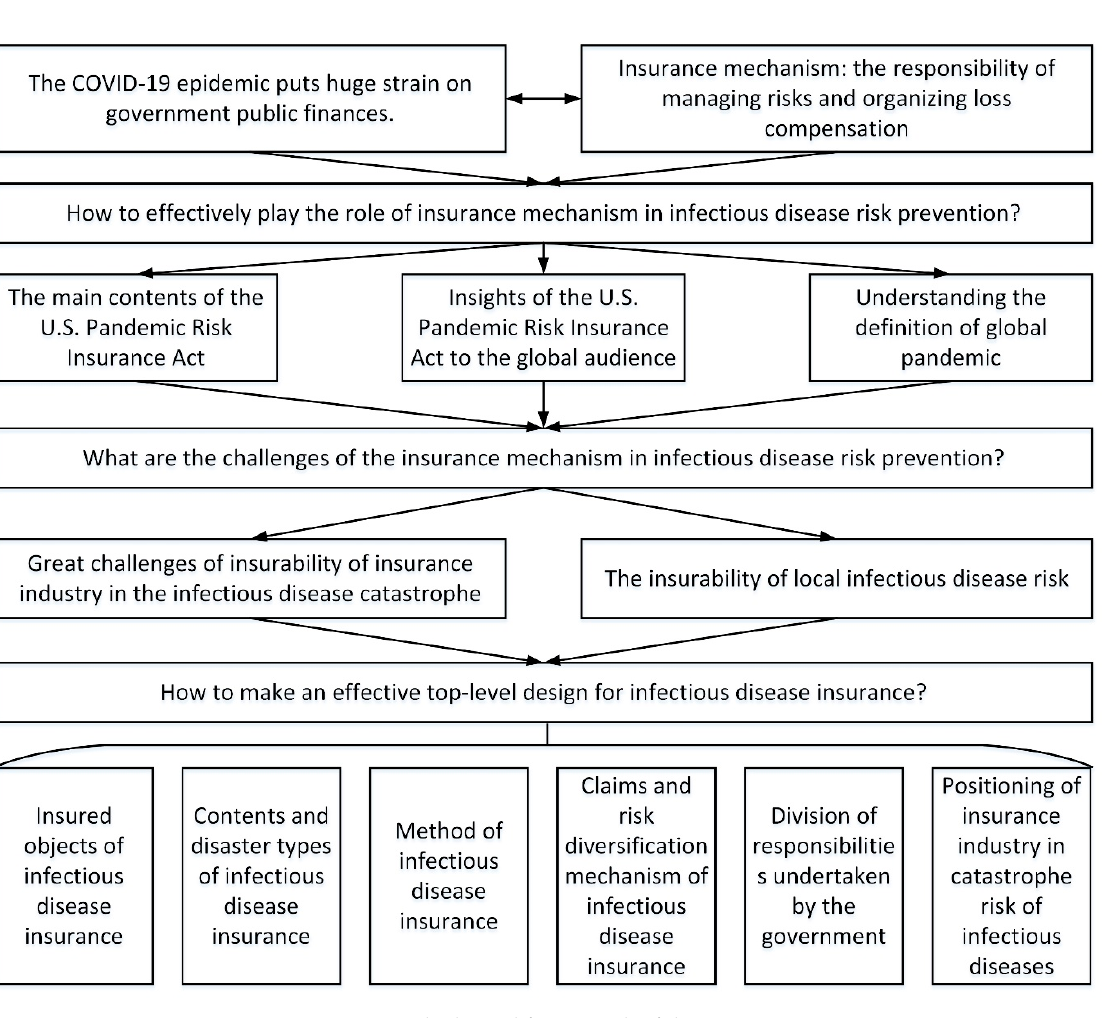
Figure 1. The logical framework of this paper.